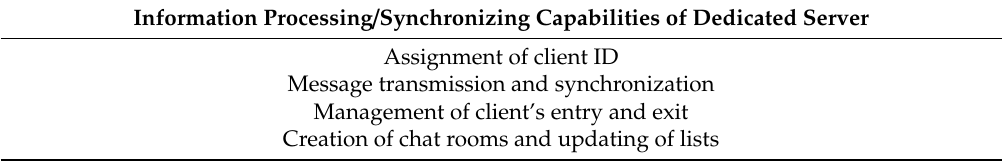
Table 3. Information processing/synchronizing capabilities of Dedicated Server.